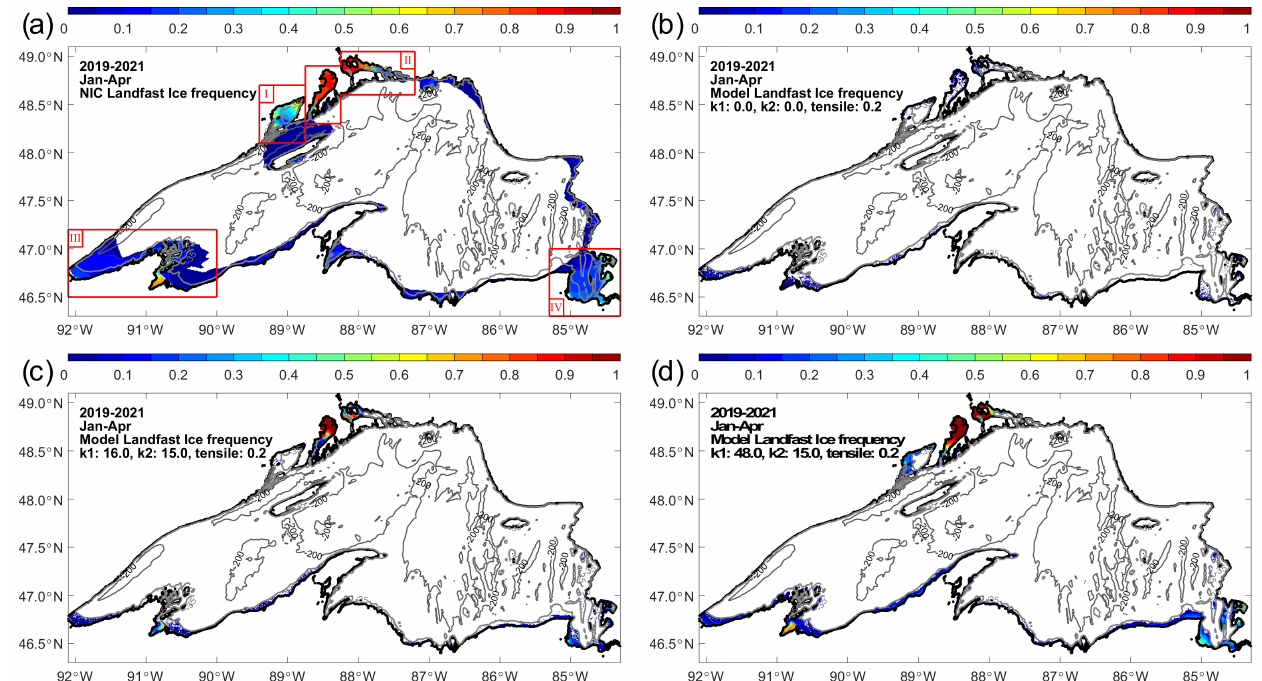
Figure 4. ( a ) Landfast ice frequency from the NIC in January to April from 2019 to 2021. ( b – d ) Same as Figure 4a but for model cases of no-basal stress ( b ), k 1 = 16 & k 2 = 15 Nm − 3 ( c ), and k 1 = 48 & k 2 = 15 Nm − 3 ( d ). The tensile strength is equal to 0.2 for the two cases with basal stress ( c , d ). The first and the second gray contours indicate the 35 m and the 200 m isobath, respectively. The 4 rectangles (domains I, II, III, & IV) indicate the sub-domains for comparing the landfast ice of the sensitivity experiments. Note that the domain II covers two bays in the